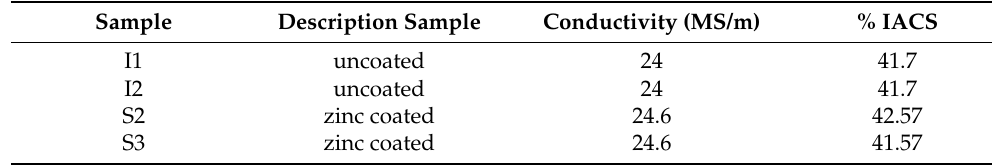
Table 1. Electrical conductivity values, calculated from the electrical resistivity, and their correspond- ing conversion to (IACS%) values of coated Al-MWCNT nanocomposite.